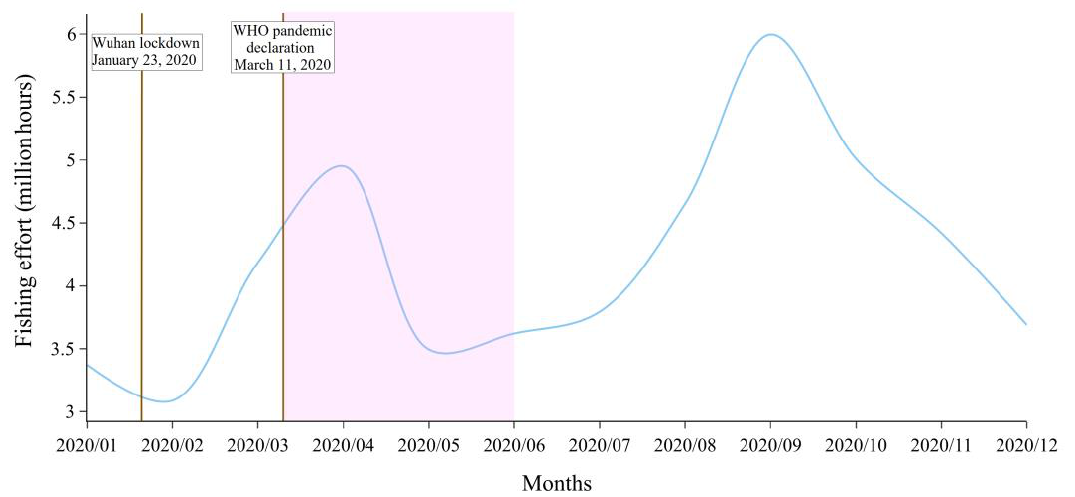
Figure 11. Fishing effort in 2020 (pink area represents the time for the first lockdown in most countries around the world).